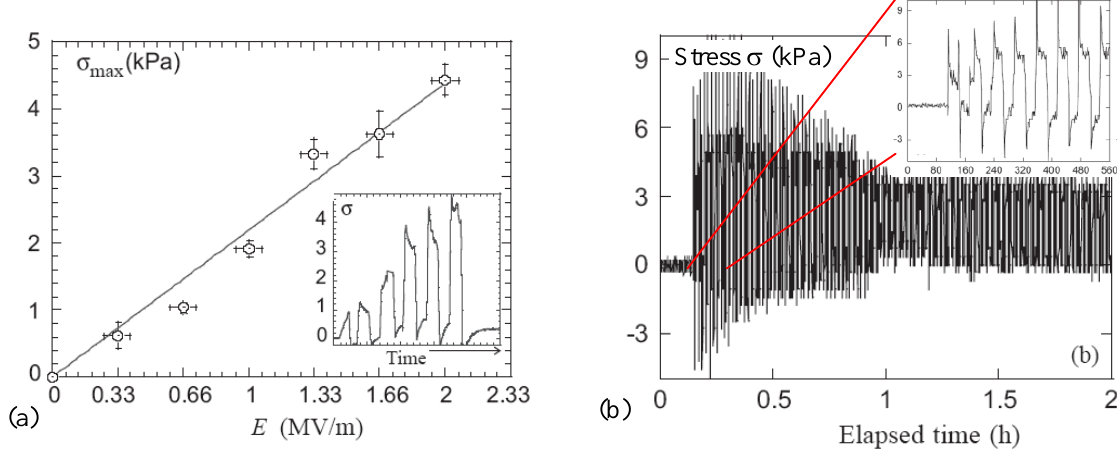
Figure 6. ( a ) Dependence of the maximum actuation stress σ strength, for the 0.02 wt% CNT sample. The inset shows the elapsed time dependence, with each cycle at increasing constant field E. ( b ) The response to an alternating field, switching on and off every 30 s, demonstrating the overall stability of the response. The inset shows the short initial period of this test, showing the high speed of the